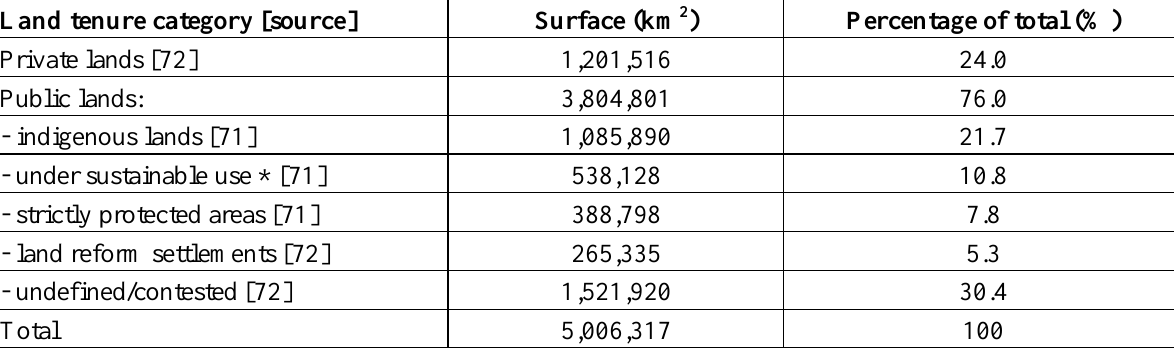
Table 2. Land tenure in the Brazilian Legal Amazon